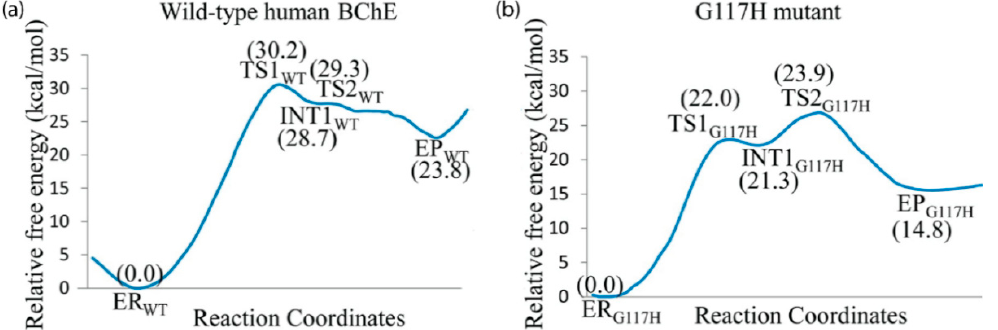
Figure 7. Free energy profiles for the reactivation of sarin-phosphorylated human BChE for ( a ) wild type hBChE and ( b ) the G117H mutant discussed in the text [155].